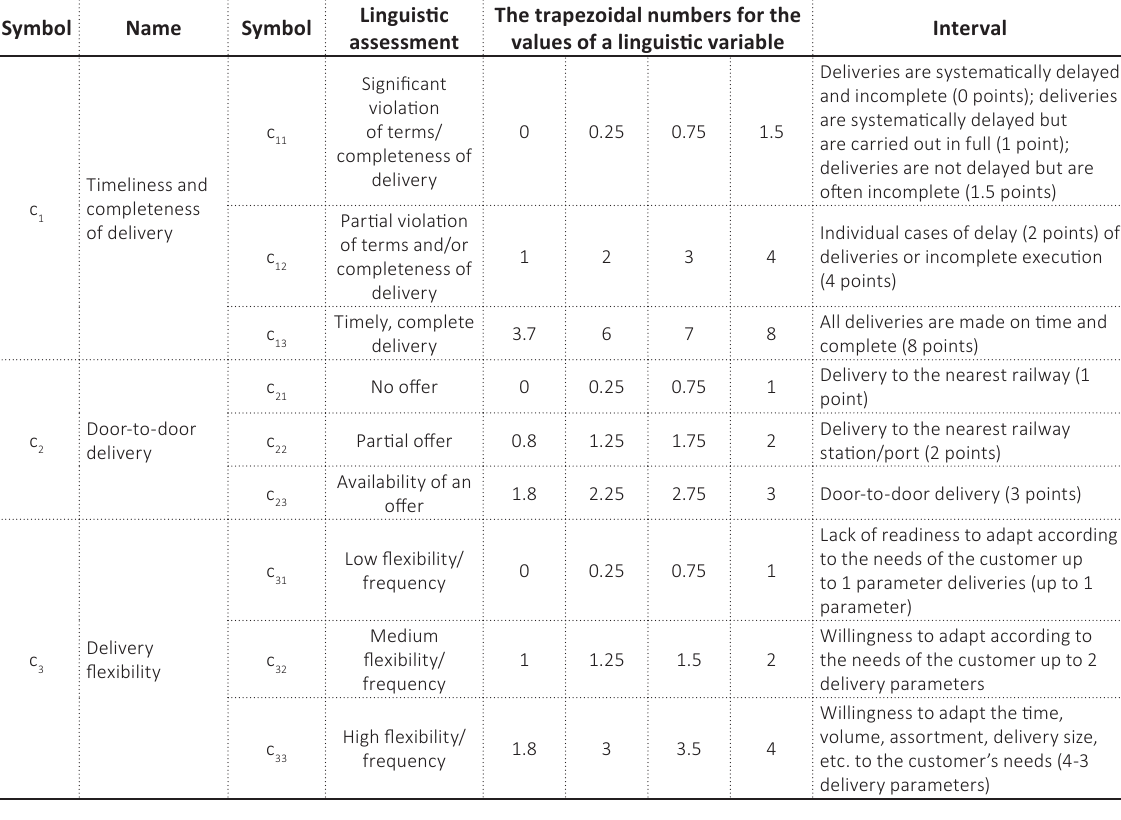
Table A4. Indicators for evaluating the level of consumer services (D)